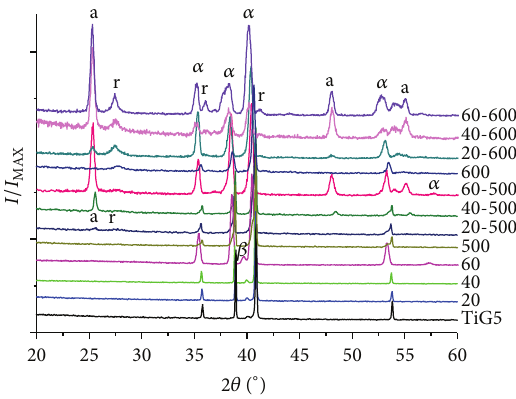
Figure 4: XRD patterns of the substrate and oxidized samples with different processes. a = anatase, r = rutile, 𝛼 = 𝛼 phase of TiG5, and 𝛽 = 𝛽 phase of